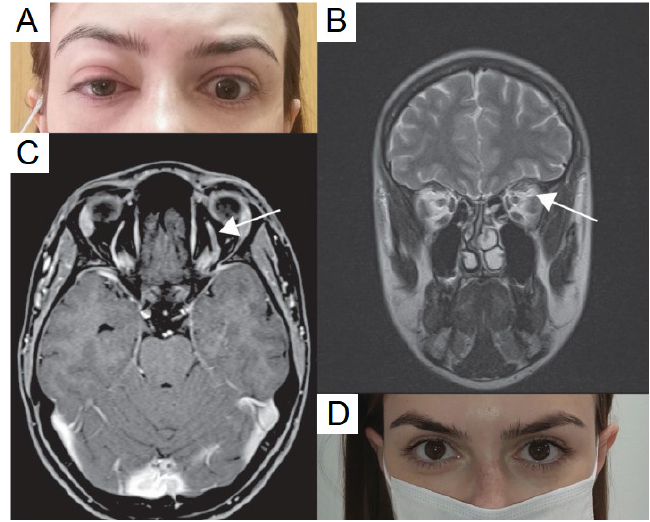
Figure 1. Clinical presentation of the vaccine-induced prothrombotic immune thrombocytopenic disorder (VIPIT) and superior ophthalmic vein (SOV) thrombosis after ChAdOx1 nCoV-19 vaccina- tion. ( A ) patient presentation at admission with marked proptosis, ( B ) contrast enhanced magnetic resonance imaging (MRI) revealed SOV thrombosis (white arrow), presented with widening SOV and filling defects, ( C ) T2 sequence further confirmed SOV thrombosis with the enhanced signal intensity of SOV (white arrow), ( D ) no symptoms after five days of treatment, published with patient’s permission. Adapted from Panovska-Stavridis, I.; Pivkova-Veljanovska, A.; Trajkova, S.; Lazarevska, M.; Grozdanova, A.; Filipche, V. A Rare Case of Superior Ophthalmic Vein Thrombosis and Thrombocytopenia Following ChAdOx1 nCoV-19 Vaccine Against SARS-CoV-2. Mediterr. J. Hematol. Infect. Dis. 2021 , 13 , e2021048; Published 1 March 2021.